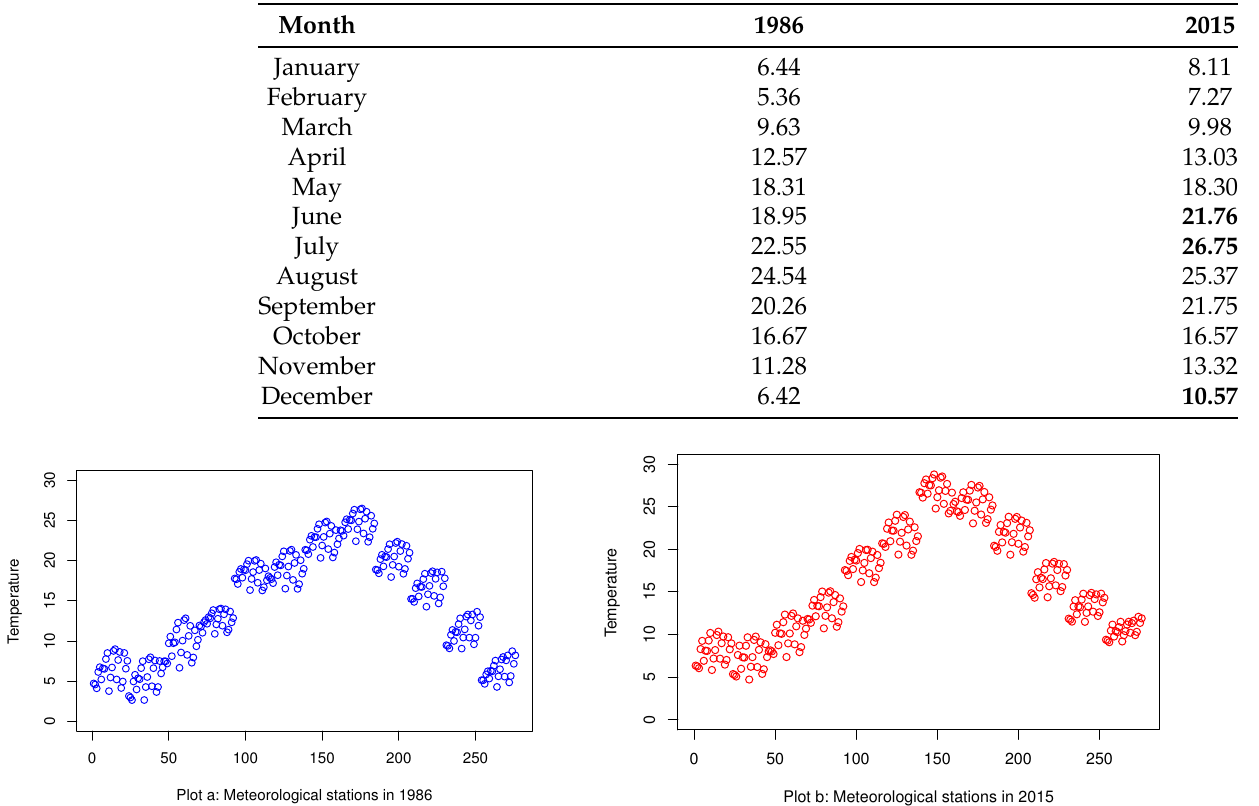
Table 2. Average temperature over 23 meteorologic stations of Campania in 1986 and 2015. The values highlighted in bold show the most relevant temperature increases in 2015.